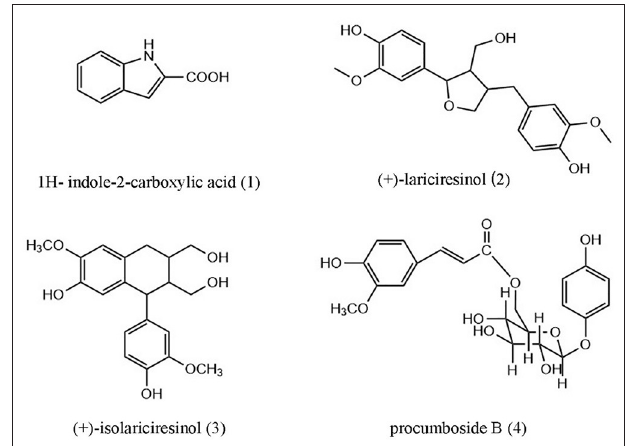
FIGURE 1 | Structures of compounds 1 – 4 from Origanum majorana